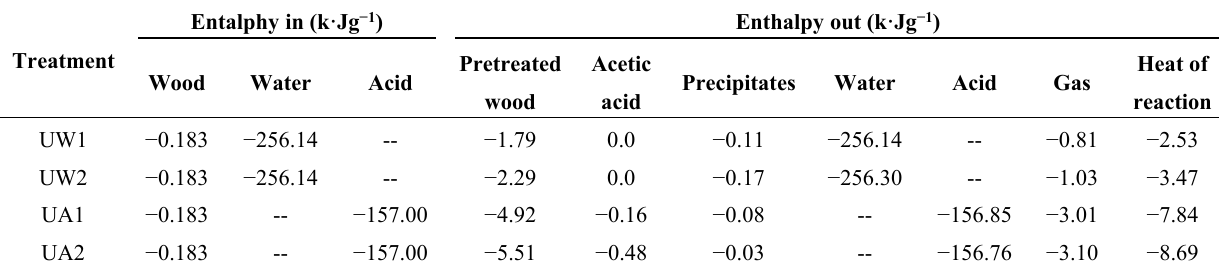
Table 6. Enthalpy and heat of reaction in HTC without and with diluted acid.